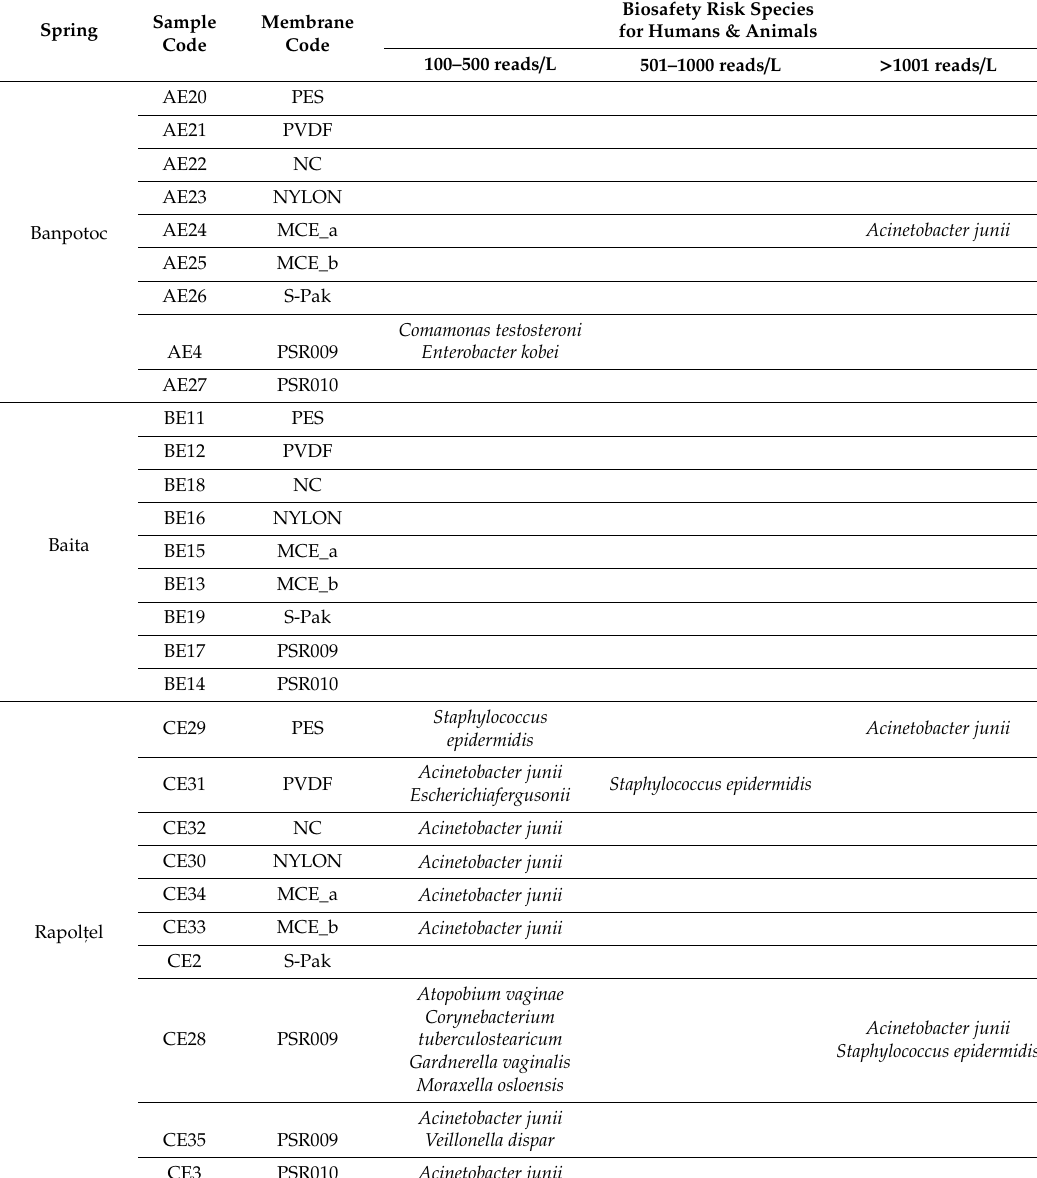
Table4. Thetestedmembranesformetabarcodingandthemostabundantidentifiedpathogenicbacteria.